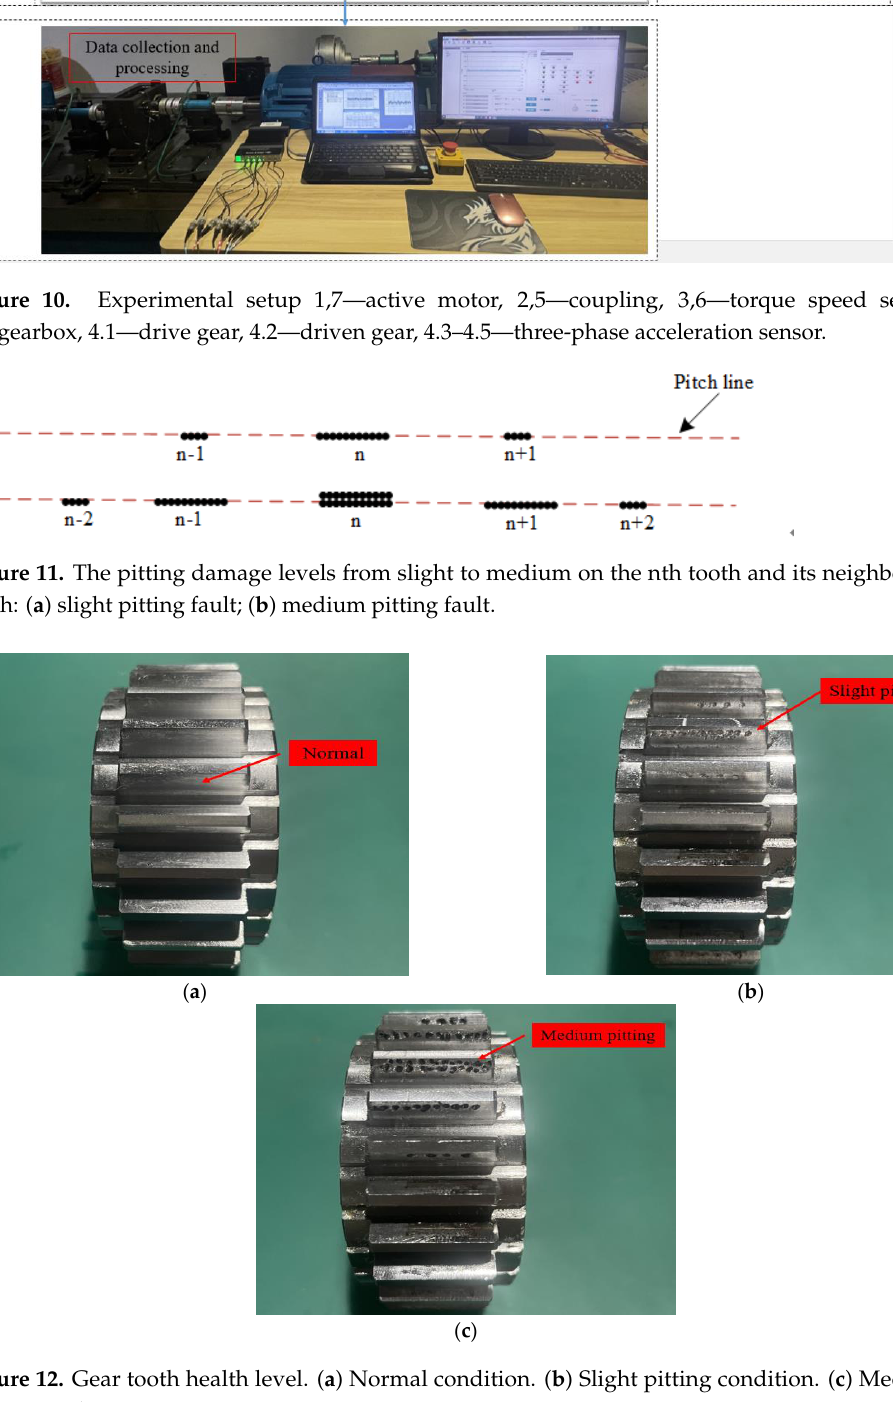
Figure 11. The pitting damage levels from slight to medium on the nth tooth and its neighboring teeth: ( a ) slight pitting fault; ( b ) medium pitting fault. A low load was applied to the pinion gear teeth for fault detection at rotational